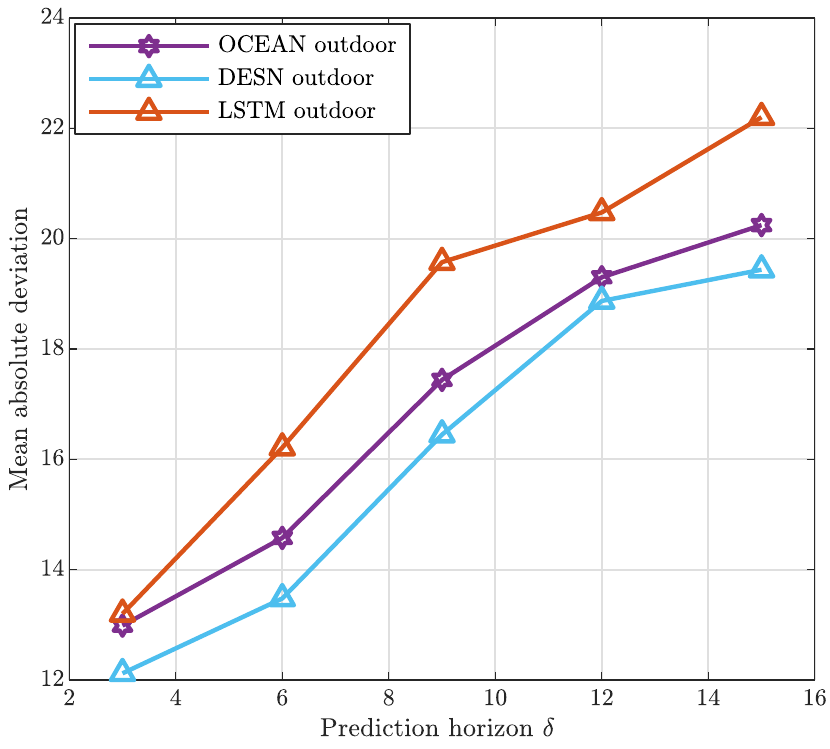
Figure 6. Outdoor mean absolute